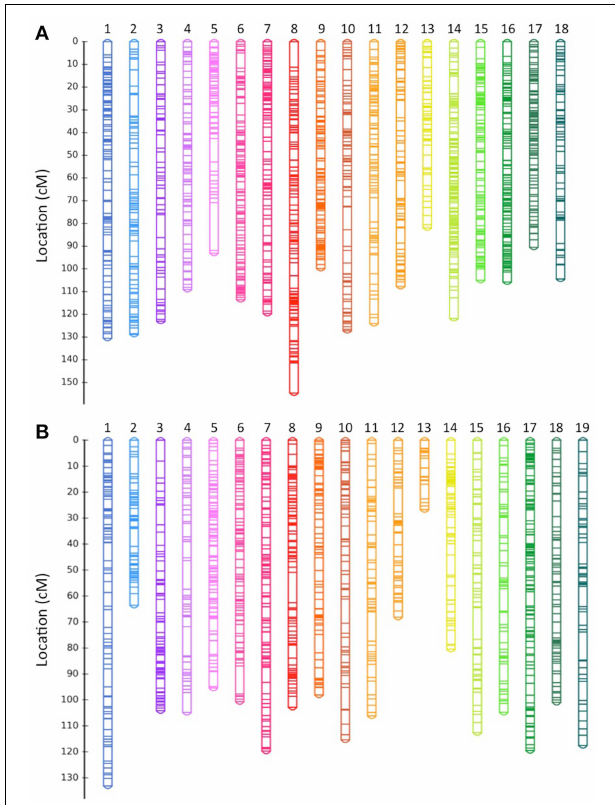
FIGURE 1 | GBS-based genetic linkage maps of rubber tree derived from F 1 progeny from (A) BPM24 × RRIM600 and (B) BPM24 × RRIC110 crosses. Linkage group numbers (assigned arbitrarily by JoinMap) are indicated at the top of each map. Details of SNP markers located on the maps are included in Data Sheet